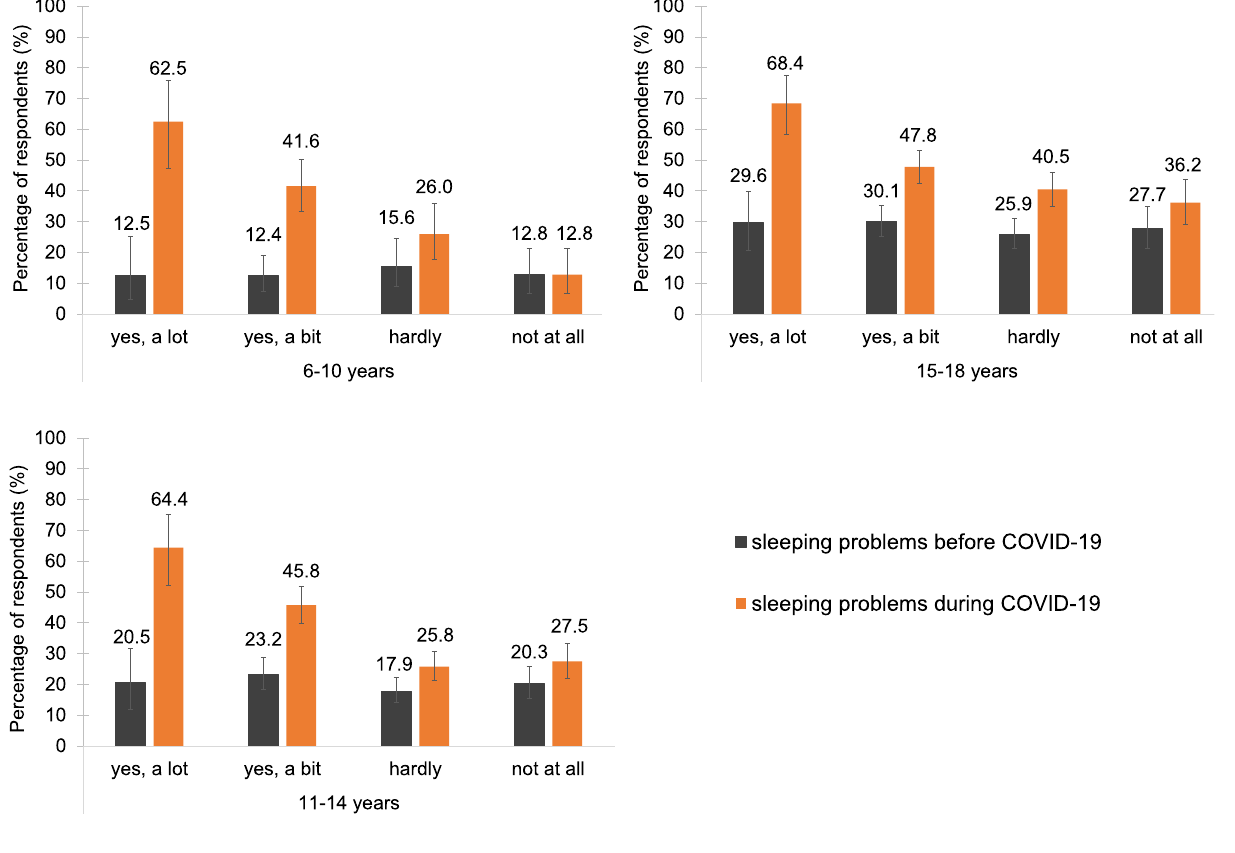
Figure 5. Sleeping problems and COVID-19 related anxiety. Reports of sleeping problems during COVID-19 were more frequent in children and adolescents being more anxious (“yes, a lot”) of COVID-19 than those being less anxious (“not at all”).